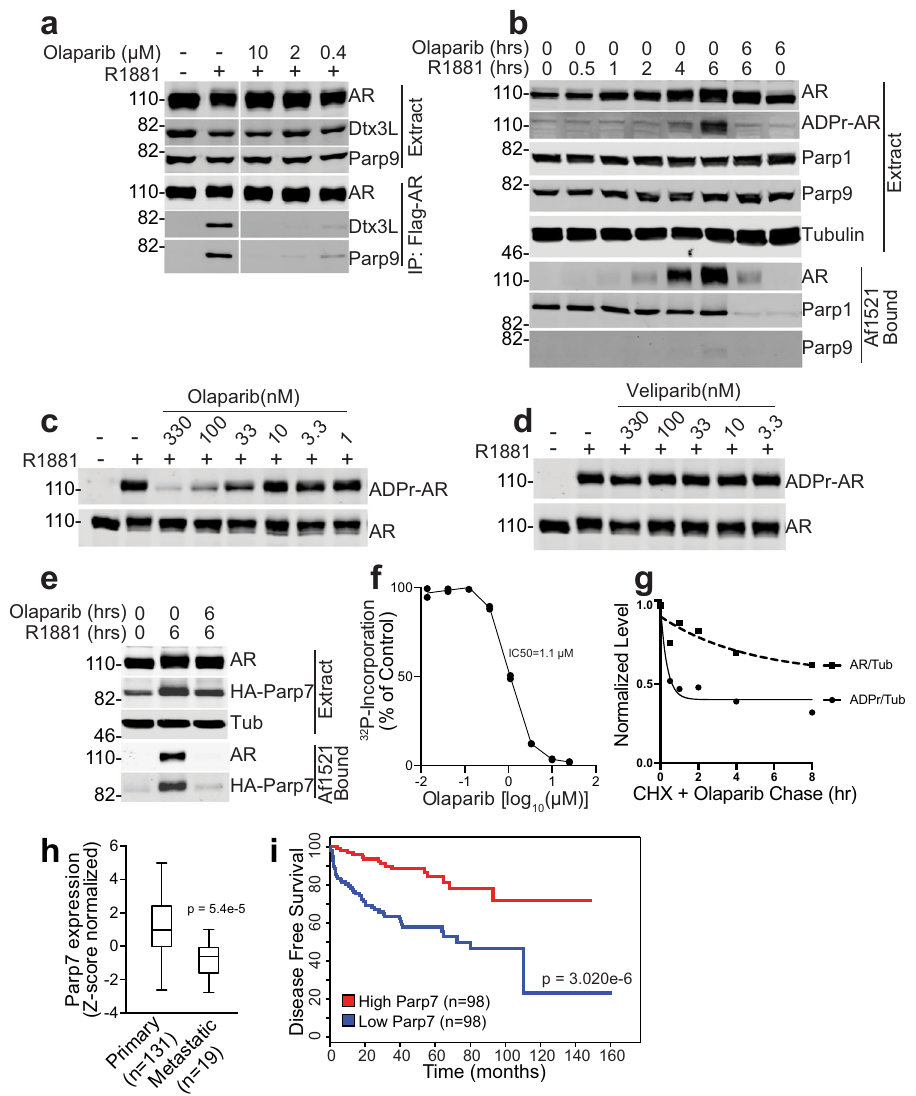
Fig. 5 Olaparib inhibits AR ADP-ribosylation and complex assembly. a Olaparib inhibits androgen-induced AR-Dtx3L/Parp9 complex formation. PC3-AR cells were treated with R1881 (2 nM) and the concentrations of Olaparib indicated. Extracts were used to IP AR, and the bound fractions were probed for AR, Dtx3L, and Parp9. b Olaparib inhibits androgen-induced AR ADP-ribosylation. PC3-AR cells were treated with R1881 and Olaparib in the combinations and times indicated. Cell extracts were used for Af1521 pulldowns, and the extracts and bound fractions were analyzed by blotting for AR, ADPr-AR, Parp1, and Parp9. c Concentration dependence of Olaparib inhibition of AR ADP-ribosylation. PC3-AR cells were co-treated with R1881 and the indicated concentrations of Olaparib, and the levels of AR and ADP-ribosylation examined by blotting. Olaparib inhibition of Parp1 automodi fi cation was veri fi ed by immunoblotting (Supplementary Fig. 21a). d The Parp1/2 inhibitor Veliparib does not inhibit AR ADP-ribosylation. PC3-AR cells were co-treated with R1881 and the indicated concentrations of Veliparib, and the levels of AR and ADP-ribosylation examined by blotting. Veliparib inhibition of Parp1 automodi fi cation was veri fi ed by immunoblotting (Supplementary Fig. 21b). e Parp7 automodi fi cation in cells and binding to Af1521 beads is inhibited by Olaparib. PC3-AR-HA-Parp7 cells were co-treated with R1881 and Olaparib for the indicated times, and cell extracts were analyzed by Af1521 pulldown and immunoblotting for AR and HA-Parp7. f Parp7 automodi fi cation in vitro is inhibited by Olaparib. Recombinant Parp7 expressed and puri fi ed from insect cells was incubated with 32 P-NAD + with a range of Olaparib concentrations, the level of automodi fi cation quanti fi ed and plotted after autoradiography. g Olaparib chase experiment indicates that AR has ADP-ribosylation sites with fast and slow turnover. PC3-AR cells were treated with R1881 overnight, and subsequently chased with Olaparib (10 μ M) and CHX (100 μ g/ml) to prevent further ADP-ribosylation and AR synthesis, respectively. The levels of AR and AR ADP-ribosylation were measured and plotted as a function of tubulin level. h Parp7 expression levels (Z-score normalized, RNA-seq data) in primary and metastatic prostate tumors. The box shows the median and the upper and lower quartiles, and the whiskers indicate the minimum and maximum. Expression levels were compared by unpaired, two-tailed t test. Further details of the analysis are contained in “ Methods ” . i Prostate cancer patient outcome strati fi ed by Parp7 expression levels (RNA-seq). Plotted is the time of disease-free survival for patients with high Parp7 levels (red) versus low Parp7 levels (blue). P value determination by a log-rank test is shown. Source data are provided as a Source data fi